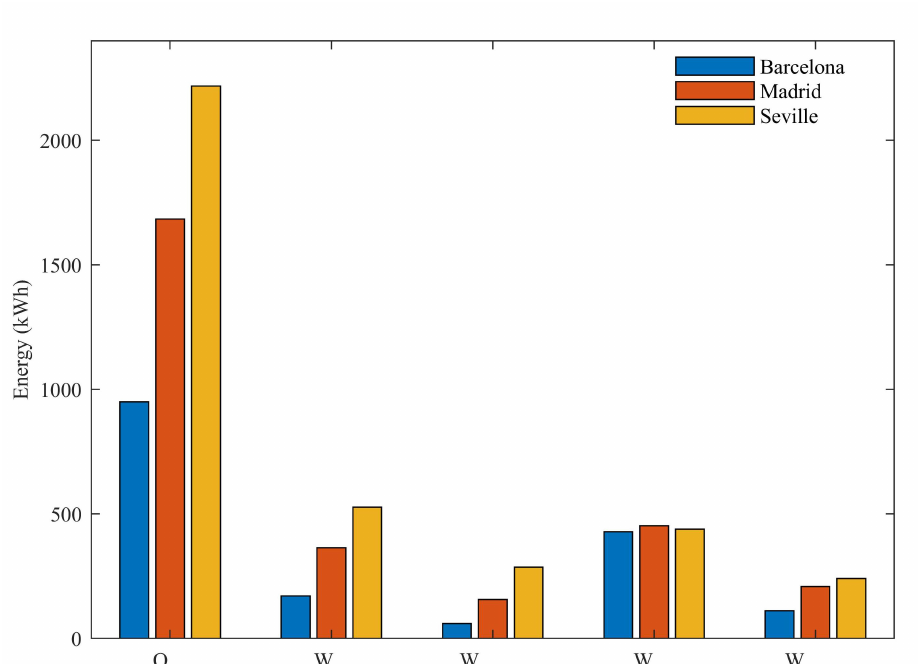
Figure 9. Results concerning the influence of the climatic region